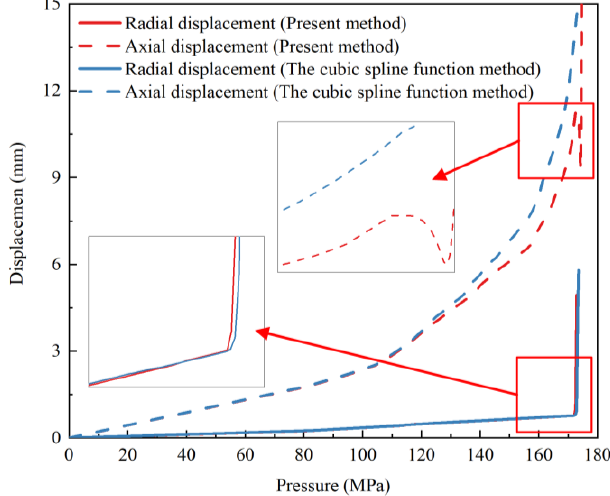
Figure 20. Comparison of numerical results of load-displacement curves between two methods.